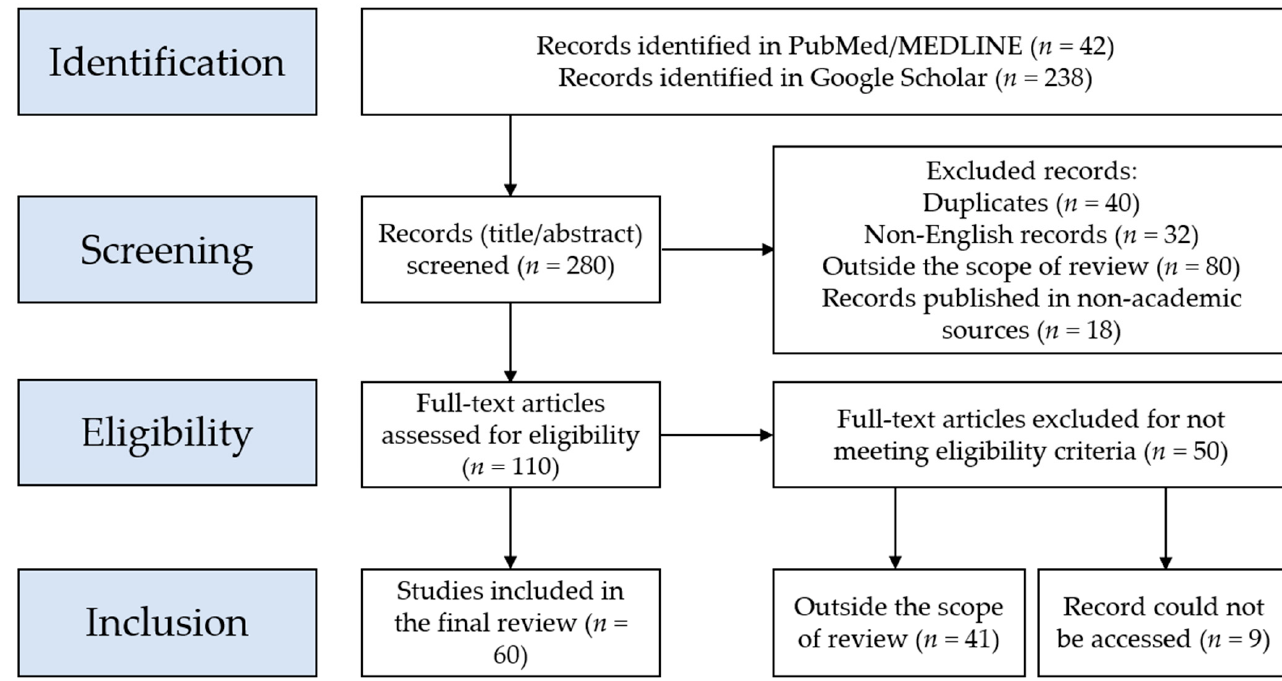
Figure 1. Flowchart of the record selection process based on the Preferred Reporting Items for Systematic Reviews and Meta-Analyses (PRIMSA) guidelines.